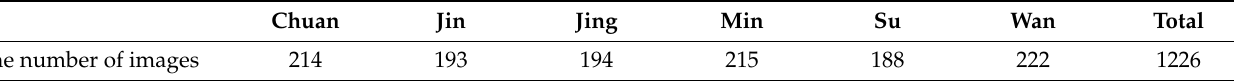
Table 2. The number of images for each architectural style class.